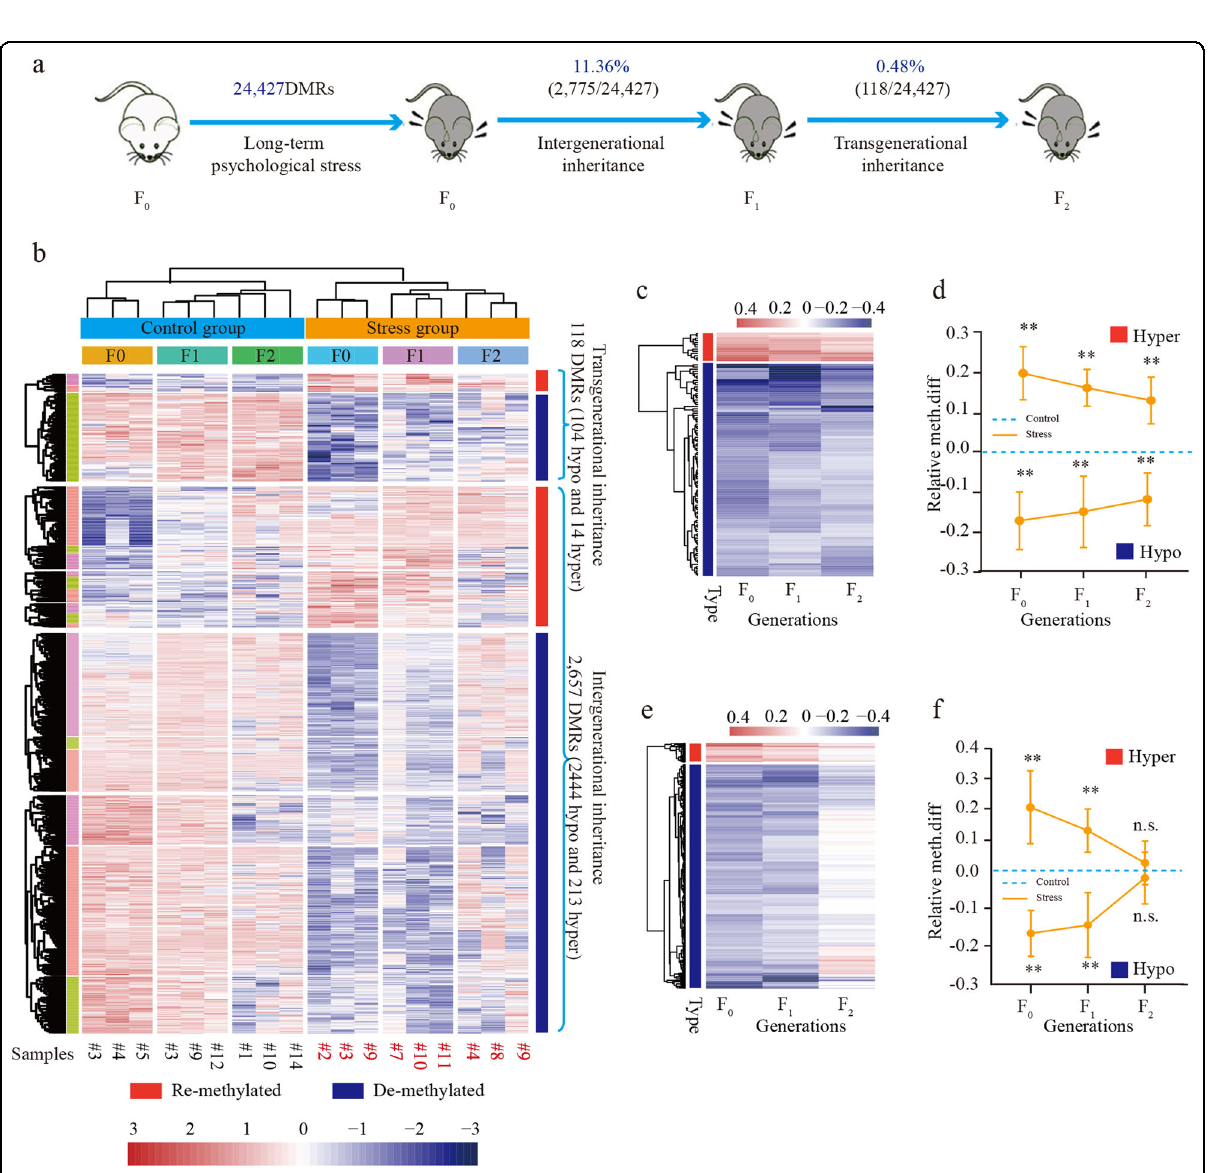
Fig. 3 Epigenetic inheritance of “ epigenetic memory ” across generations. a Proportions of the intergenerationally and transgenerationally inherited DMRs across generations. b Heatmap of the DNA methylation status of all epigenetically inherited F 0 -DMRs. c Heatmap of the Δβ values of the transgenerationally inherited DMRs. d Tendencies of the Δβ values of the transgenerationally inherited DMRs in advanced generations. e Heatmap of the Δβ values of the intergenerationally inherited DMRs. f Tendencies of the Δβ values of the intergenerationally inherited DMRs in advanced generations. ** t -test p -value < 0.01; n.s. no signi fi cant, t-test p -value >